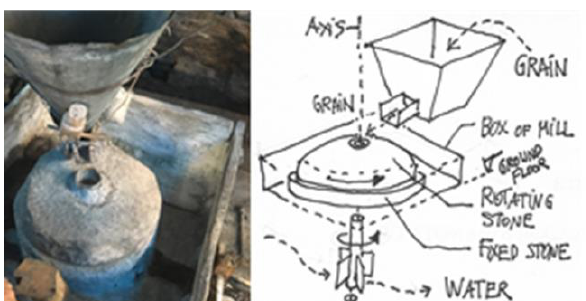
Figure 11. Mill machinery (Authors).